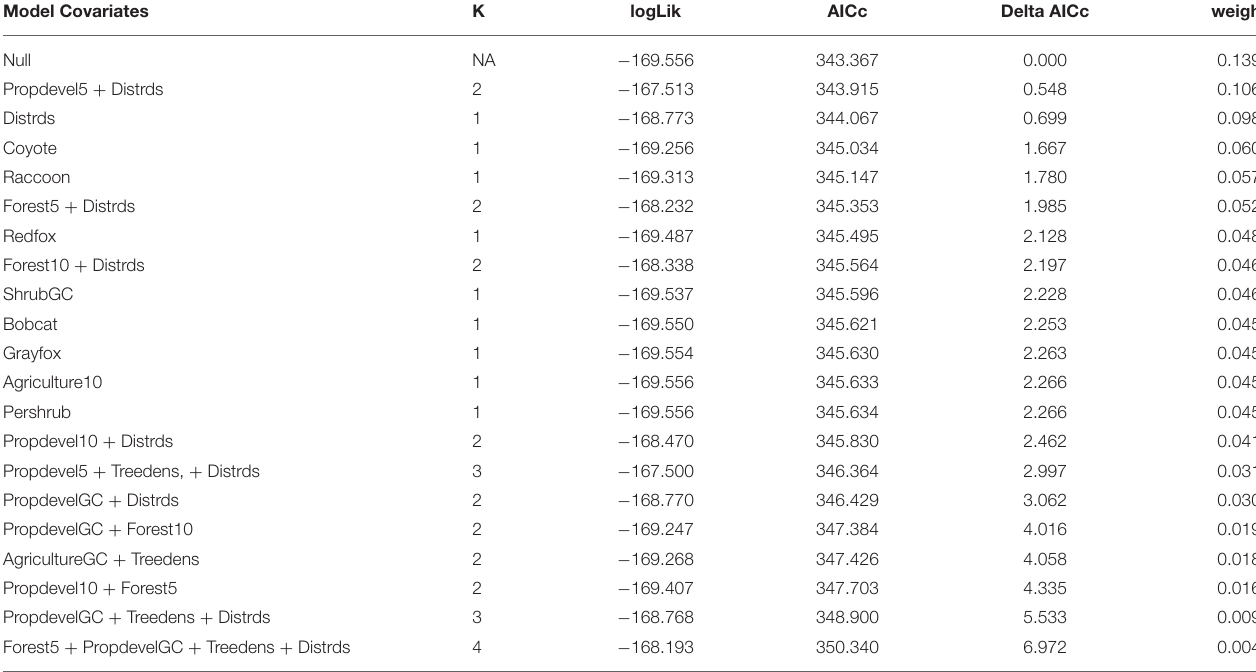
TABLE 7 | Candidate model set for D. virginiana . Model